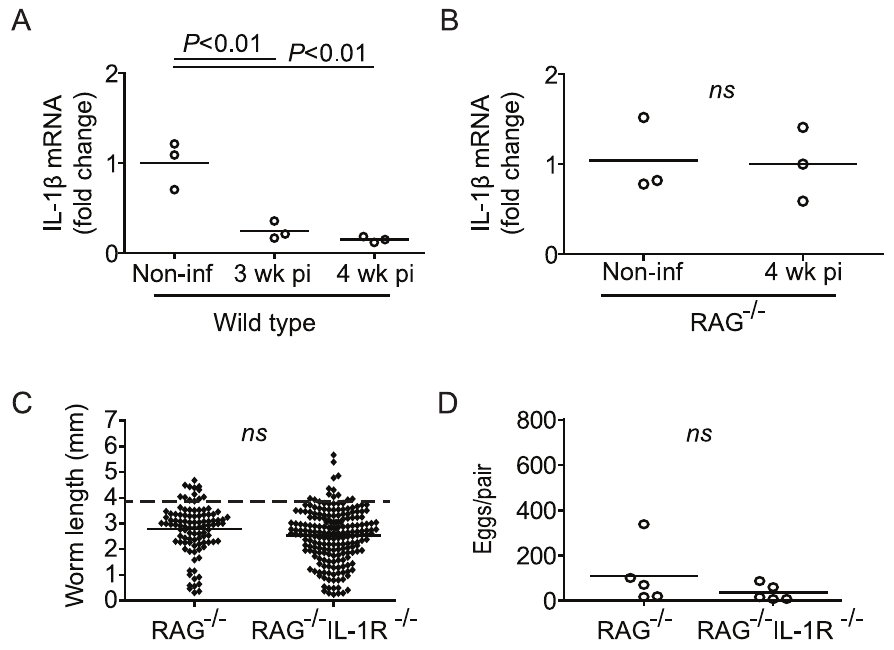
Figure 3. Impaired S.mansoni development in RAG 2 / 2 mice correlates with maintenance of IL-1 b transcription. (A and B) Groups of wild type (A) and RAG 2 / 2 mice (B) were infected percutaneously with S. mansoni cercariae, euthanized at the indicated time points and spleens removed for analysis of IL-1 b mRNA levels by real-time PCR. Horizontal bars represent mean values for each experimental group. For wild type mice (A), P values were calculated by ANOVA with Tukey’s post-test. For RAG 2 / 2 mice (B), P value was calculated using the Mann Whitney test. (C) Length of male worms and (D) liver egg burdens from S. mansoni -infected RAG 2 / 2 and RAG 2 / 2 IL-1R 2 / 2 mice at 6 weeks p.i. Horizontal bars represent mean values for each experimental group. P values were determined using student’s T-test with Welch’s correction and the Mann Whitney test. Dashed line in C indicates the average length of male S. mansoni worms recovered from wild type mice at day 42 post infection (3.9 mm).